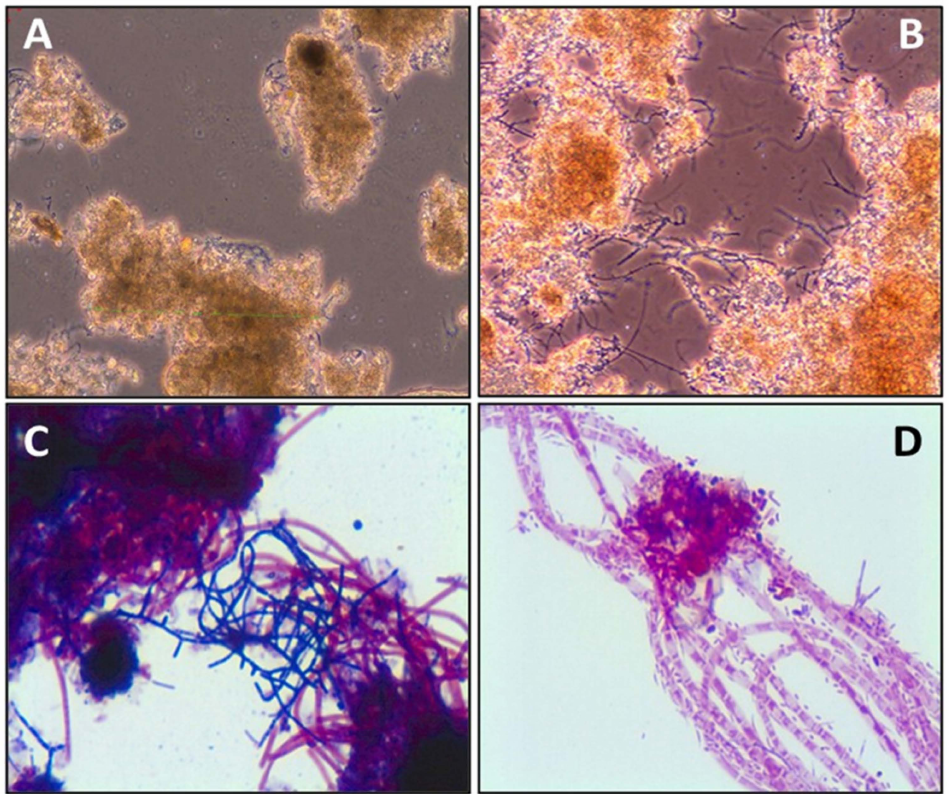
Figure 1. Wet mount of large, compact, firm, well-settling flocs ( A ), loose flocs with inter-floc filament bridging ( B ), Gram stain of Gram-negative Eikelboom Type 0092 and Gram-positive Gordonia amarae - like organisms, and ( C ) Gram stain of Gram-negative Type 021N ( D